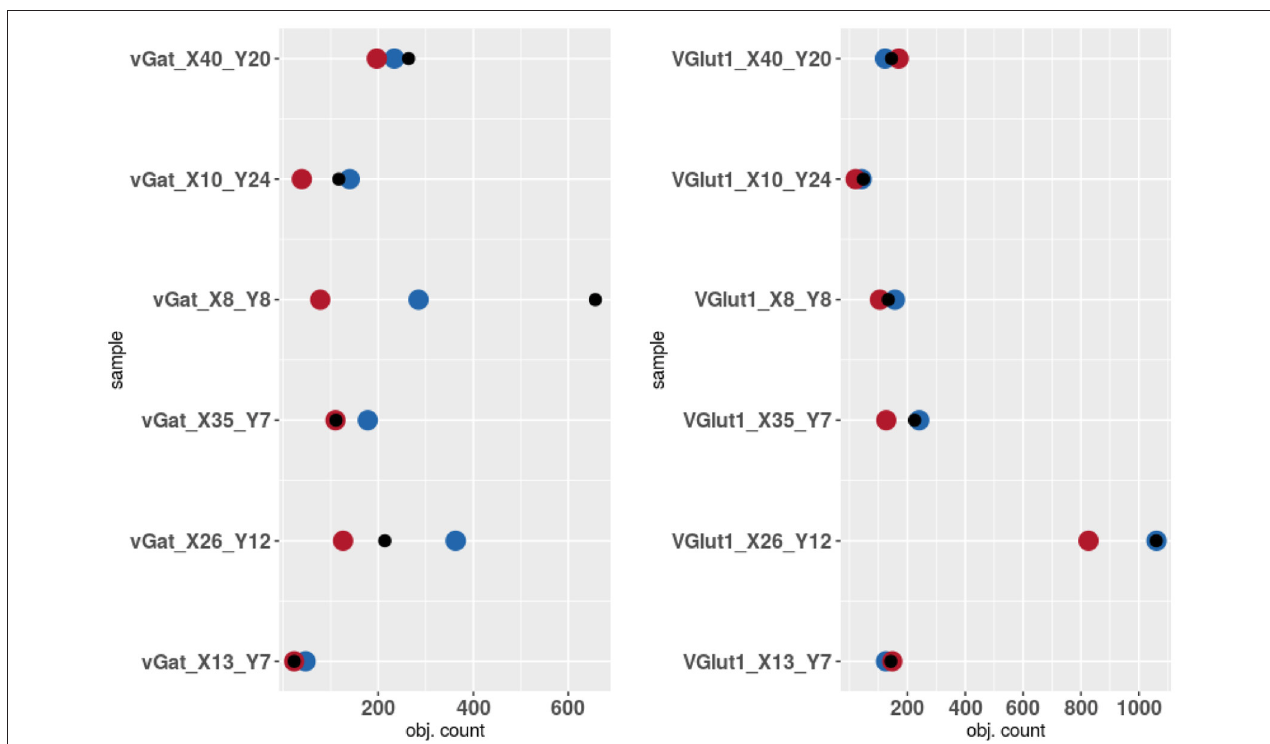
FIGURE 5 | Results of the validation. Experts 1 and 2 are represented by red and blue points while algorithm counts are marked by black points.